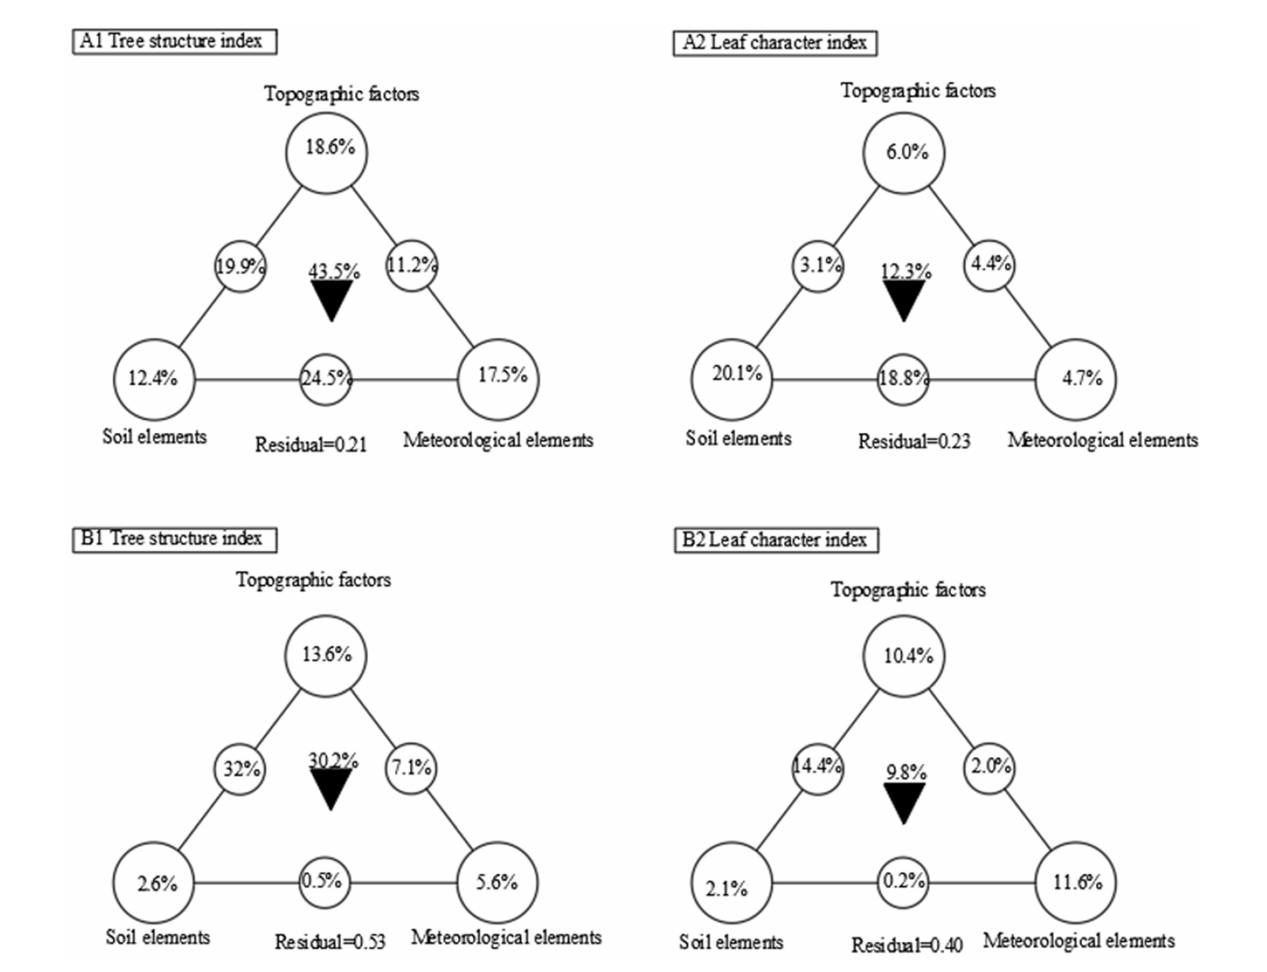
FIGURE 4 The single and combined effects of meteorological factors, topographic factors and soil factors on tree structure of B. ceiba using variance decomposition method. “ ▼ ” represent the combined effects of different factors, A1 , A2 :Mengla area; B1 , B2 :Yuanjiang